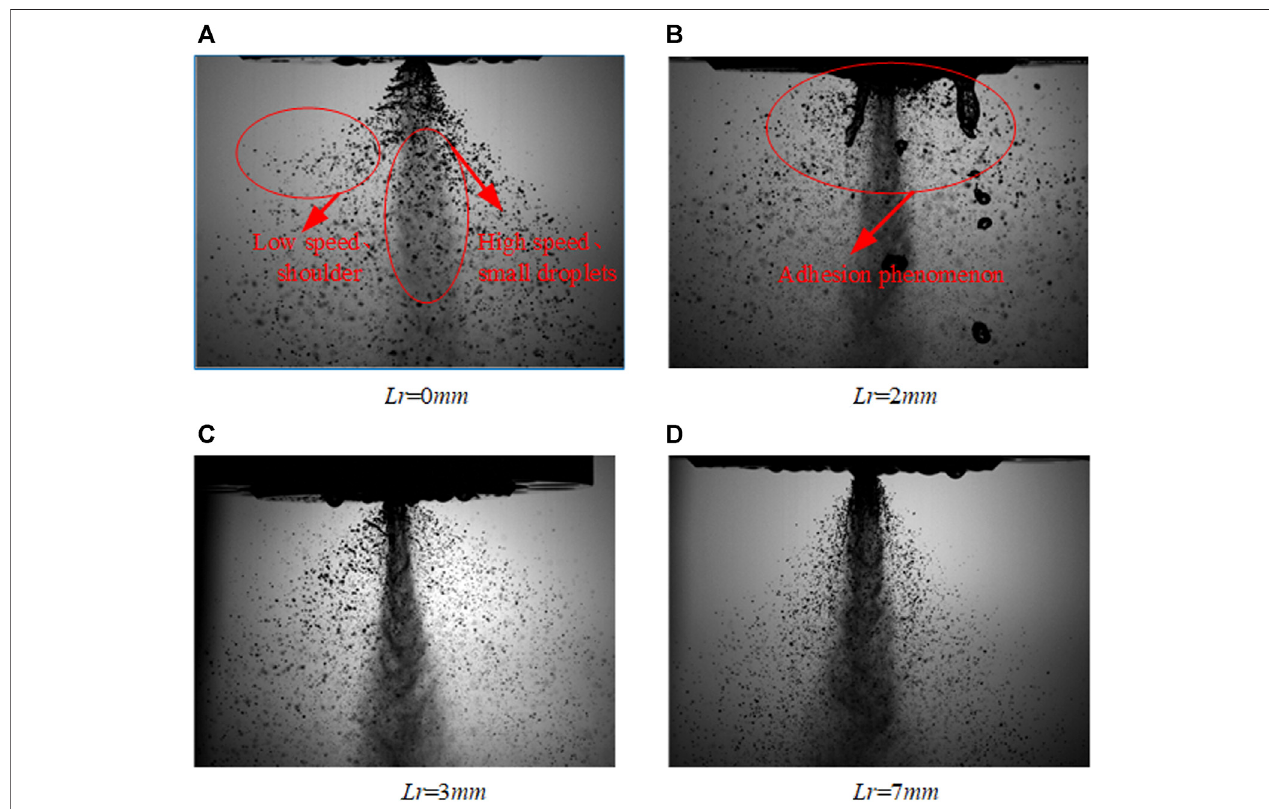
FIGURE 6 | Effect of recess on self-pulsation spray pattern ( m l (cid:2) 20 g/s, m g (cid:2) 6.8 g/s).